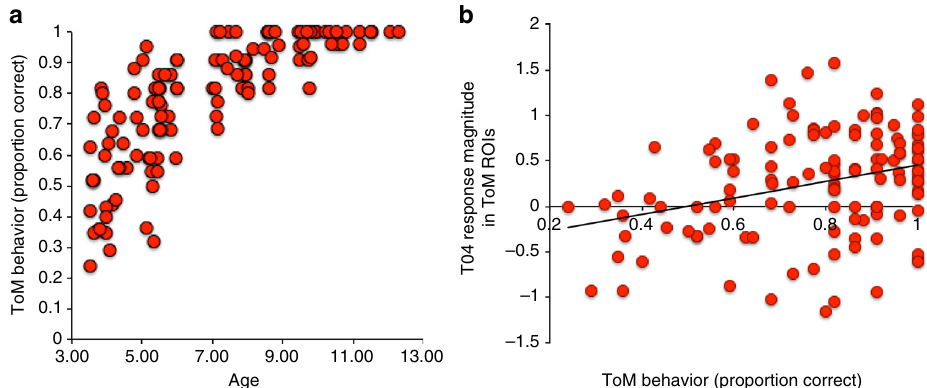
Fig. 1 Theory of mind behavioral performance. a Theory of mind behavioral performance (proportion correct; y axis) of all children ( n = 122) by age in years ( x axis). b Average response magnitude in ToM network to peak timepoint of event T04 (Peck returning to Gus, donning protective gear), per child ( y axis), by theory of mind behavioral performance (proportion correct; Supplementary Fig. 1, and Supplementary Table 2 for details about the regions of interest.